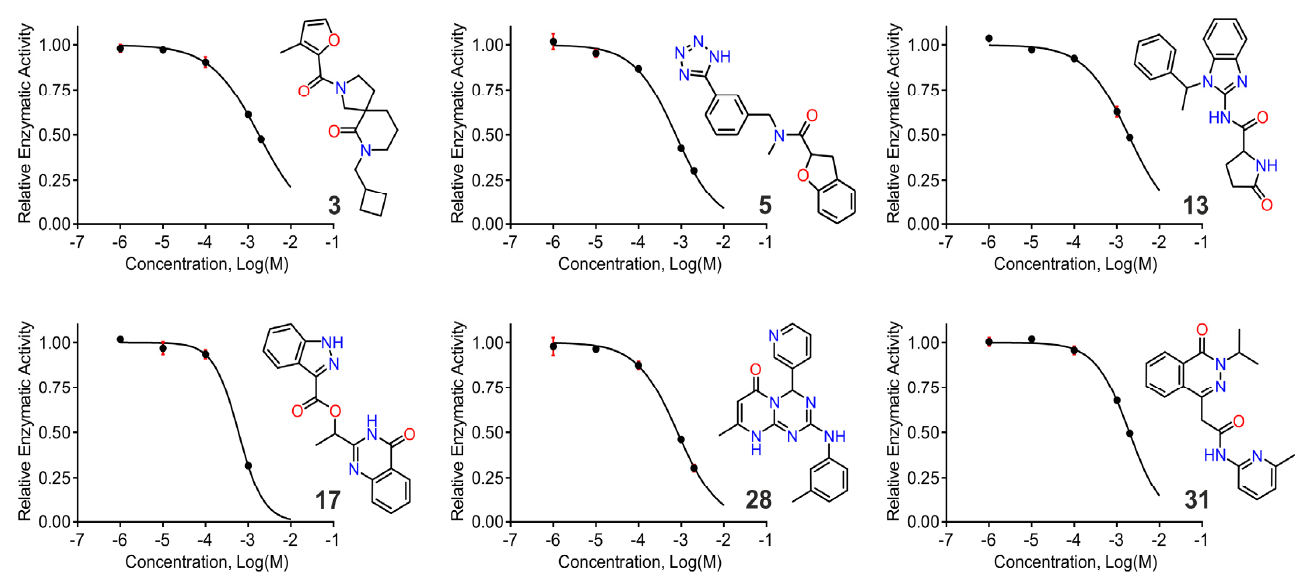
Figure 4. Representative titrations showing the dose-dependent decrease in hydrolysis of the small substrate Leu-AMC by IRAP upon addition of compounds. The structure of the corresponding compound is indicated in each panel and error bars indicate standard deviation that is only shown if significantly larger than the data point size. Solid lines represent fits to a variable-slope inhibitor vs response model using Graphpad prism™.